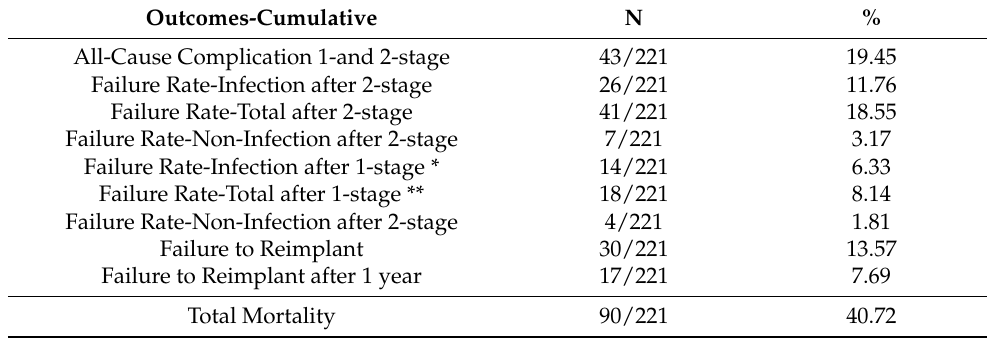
Table 1. Outcomes. Non-infection failure refers to mechanical failure requiring operative intervention.